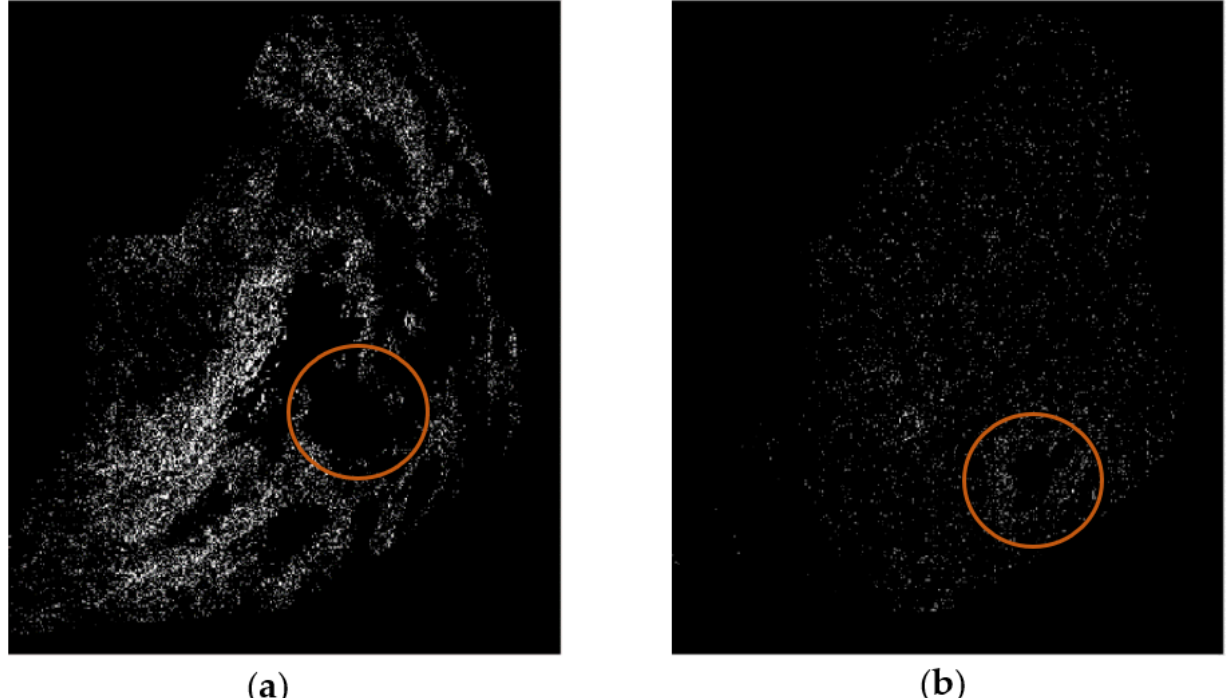
Figure 6. Image subtraction examples with the solar region highlighted. ( a ) Before installing the neutral density filter and ( b ) after installation.